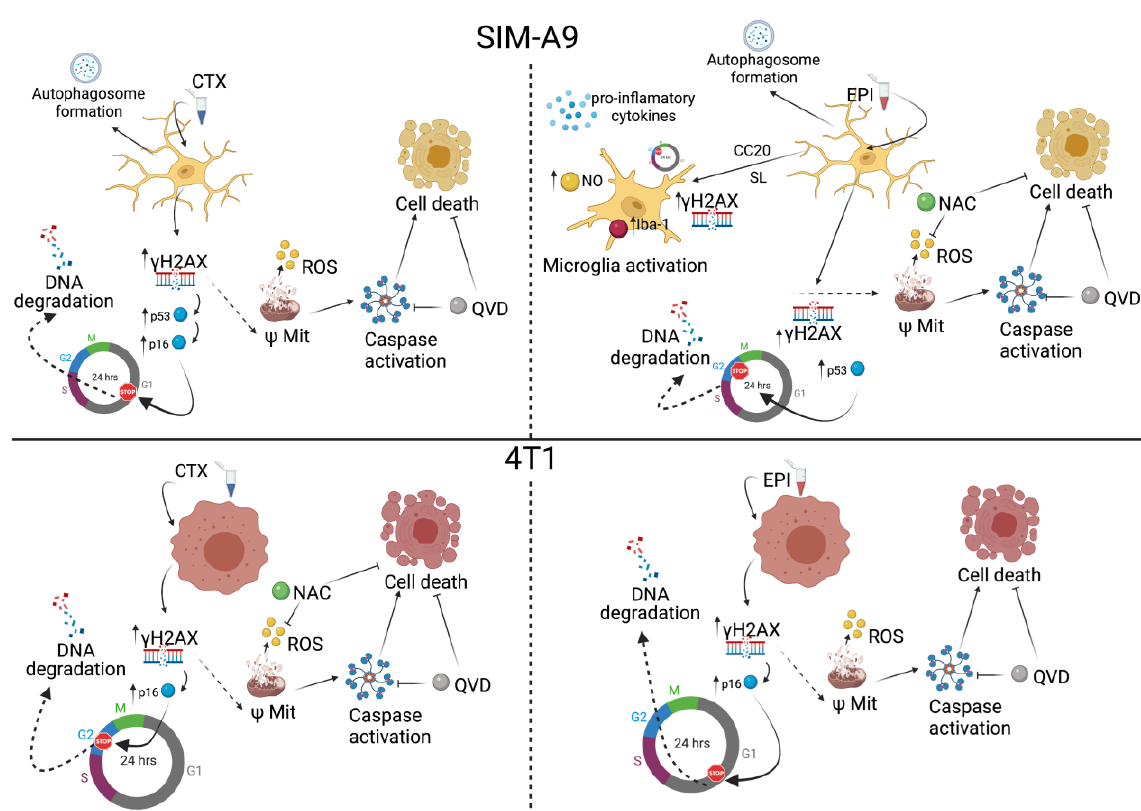
Figure 8: Chemotherapy effect in microglia and breast cancer cells. CTX induces DNA damage and cell cycle arrest, as well as mitochondrial alterations and increase in ROS production leading to ROS-dependent cell death in breast cancer cells (down left), but not in microglia cells (upper left). Caspase activation and caspase-dependent cell death are also observed in both cell lines. In microglia, CTX treatment induces autophagosome formation. EPI induces DNA damage and cell cycle arrest, as well as mitochondrial alterations and increase in ROS production leading to ROS-dependent cell death in microglia (upper right), but not in breast cancer cells (down right). Caspase activation and caspase- dependent cell death are also observed in both cell lines. Furthermore, EPI also induces autophago- some formation in microglia. Finally, CC 20 and sub-lethal concentrations of EPI induce DNA damage, cell cycle arrest and microglia activation, increasing nitric oxide production and pro-inflammatory cyto- kine release in SIM-A9